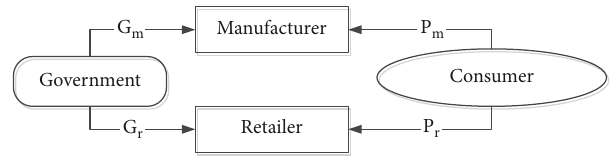
Figure 1: The structure of the supply